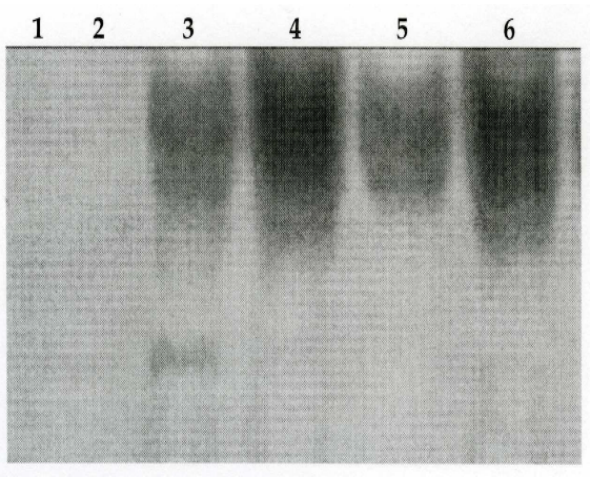
Figure 4: Activation of Nuclear Factor- (cid:1) B (NF- (cid:1) B) in A549 Cells by Ozone and DEP following Ozone